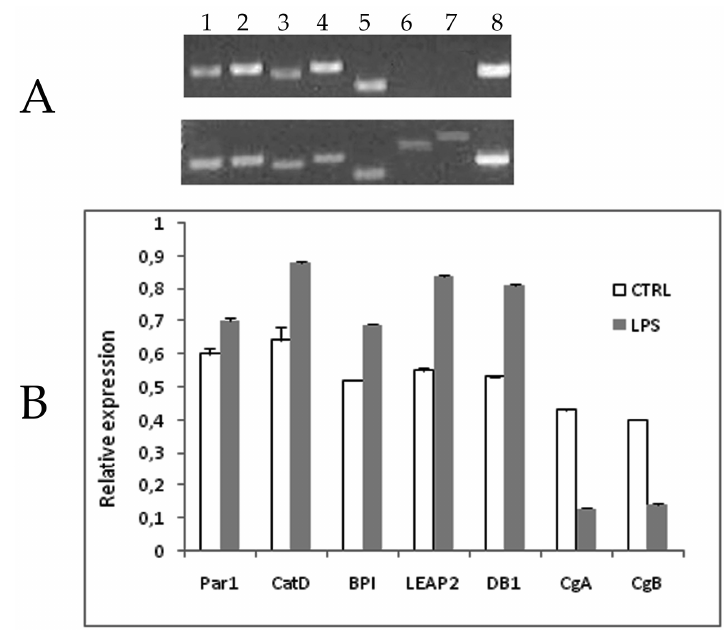
Figure 8. RT-PCR analysis of AMP expression in adult zebrafish challenged by LPS/LTA injection: (1) parasin I (Par1), (2) Cathepsin D (CatD), (3) BPI, (4) LEAP-2, (5) DB1, (6) CgA, (7) CgB, and (8) β -Actin. ( A ) samples treated with LPS (above line), and untreated control (below line); ( B ) densitometric analysis performed by Totallab software; in abscissa: antimicrobial peptides, in ordinate: relative expression of AMPs. Results were obtained from a mean of triplicate experiments. Statistically different (Student t -test, two tails) not treated (CTRL) vs. LPS p < 0.001 for all AMPs tested. Data represented the mean ± standard deviation of three different experiments of LPS injection in adult zebrafish.